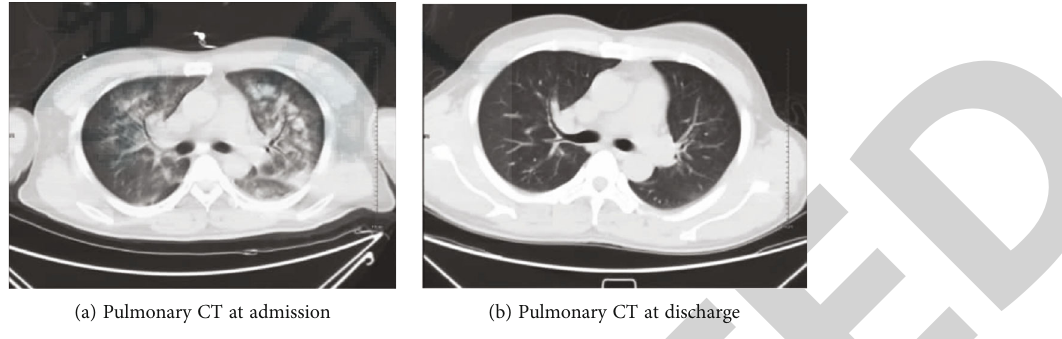
Figure 1: CT image of pulmonary edema caused by carbon monoxide